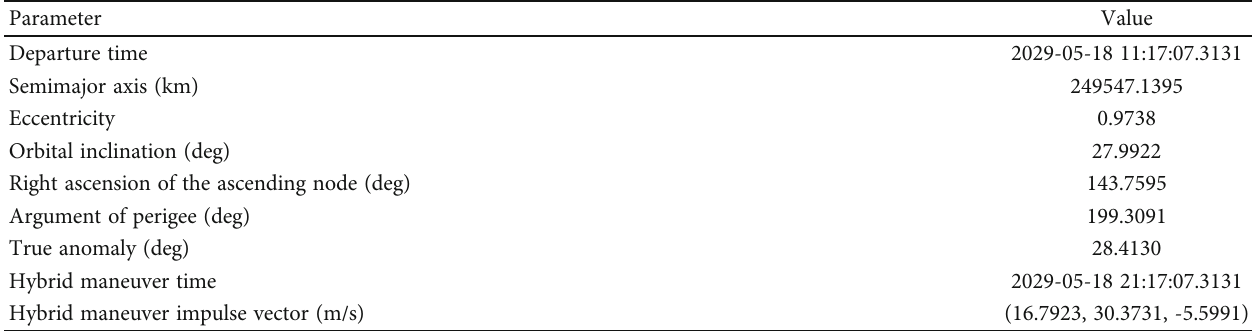
Table 2: The results of the single-impulse abort orbit (when K